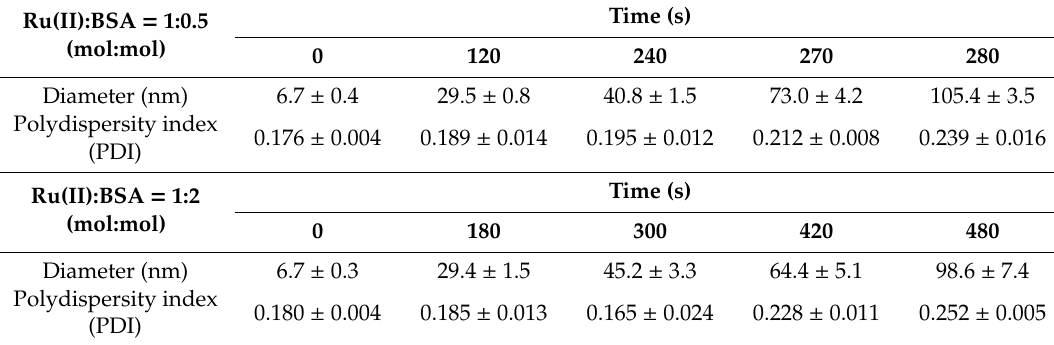
Table 1. Size control of BSA NPs through illumination time at different mole ratios of initiator to BSA. Data were collected from dynamic light scattering (DLS) measurements and presented as mean ± SD, n =